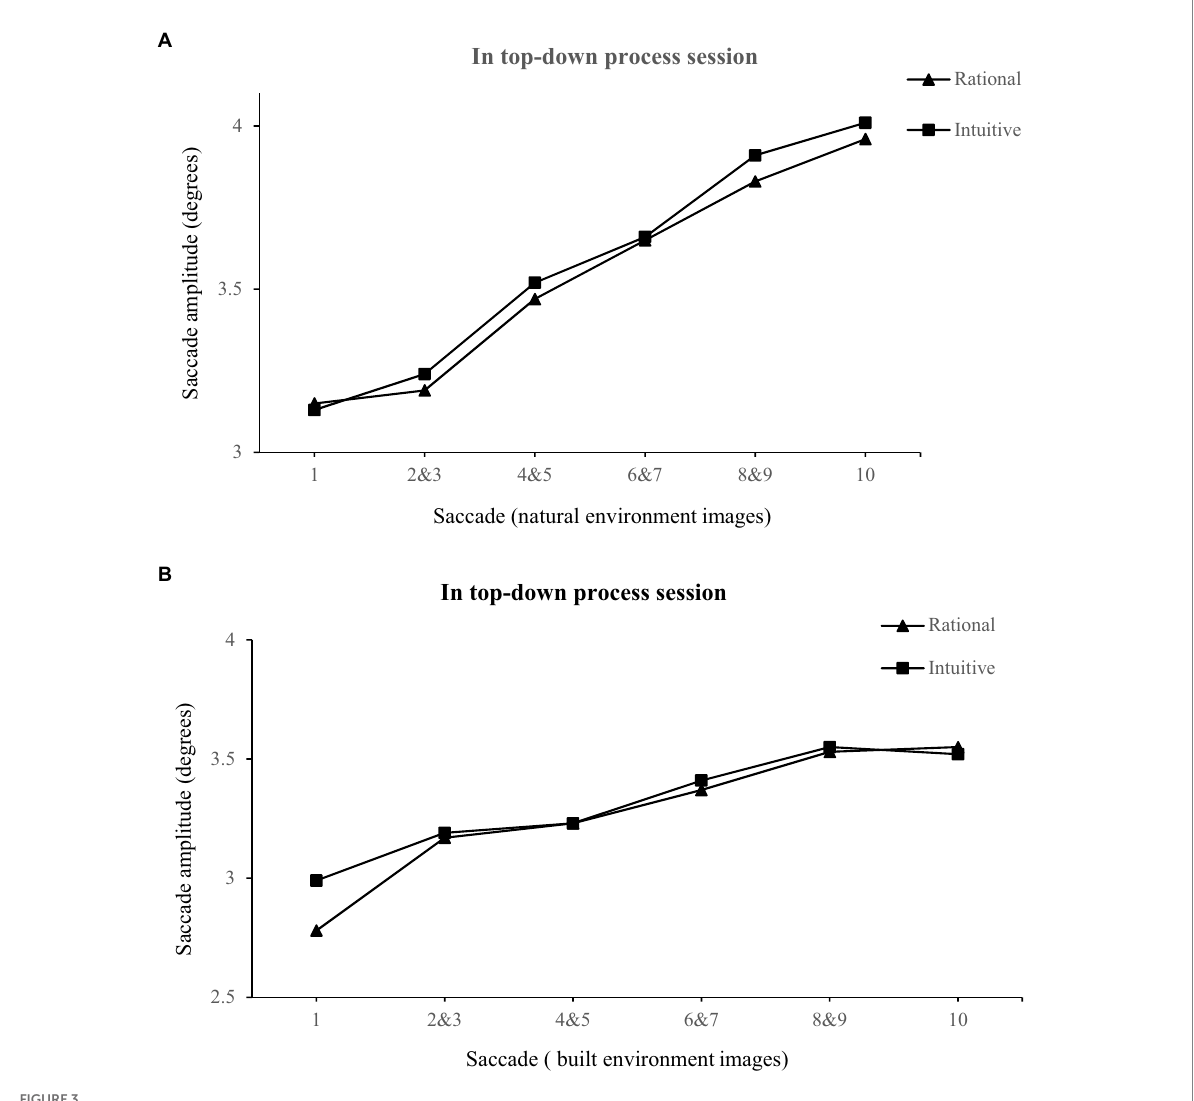
FIGURE 3 Saccade length initially increases over the viewing interval in aesthetic preference decision-making task.